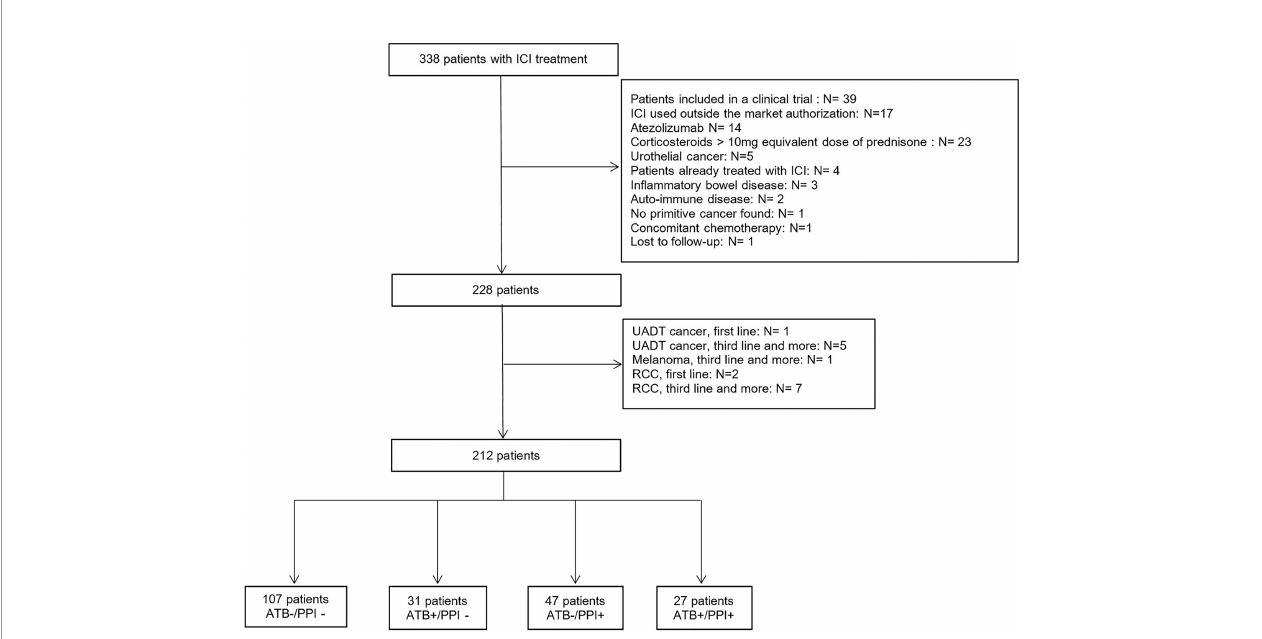
FIGURE 1 | Flowchart of the study population. ATB, Antibiotics; ICI, Immune Checkpoint Inhibitors; PPI, Proton-pump inhibitors; RCC, Renal Cell Carcinoma; UADT, Upper Aero-Digestive Tract.